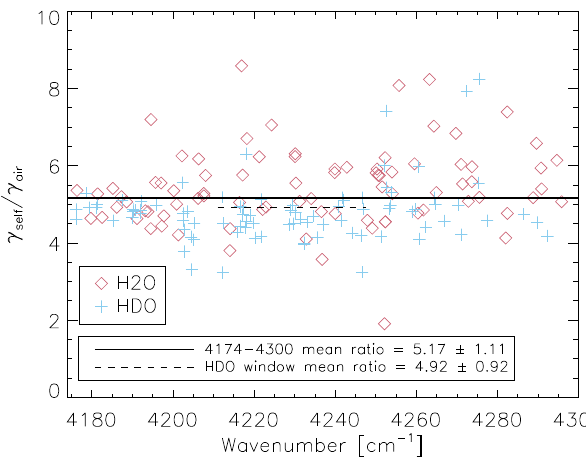
Fig. 2. Ratios between the self-broadened and air-broadened half- widths of the original Jenouvrier et al. (2007) spectroscopy. Plotted for the 174 lines with a line intensity stronger than 10 − 25 cm − 1 (moleculecm − 2 ) − 1 . The solid and dashed lines indi- cate the mean ratio for the 4174–4300cm − 1 and the HDO retrieval window (4212–4248cm − 1 ),